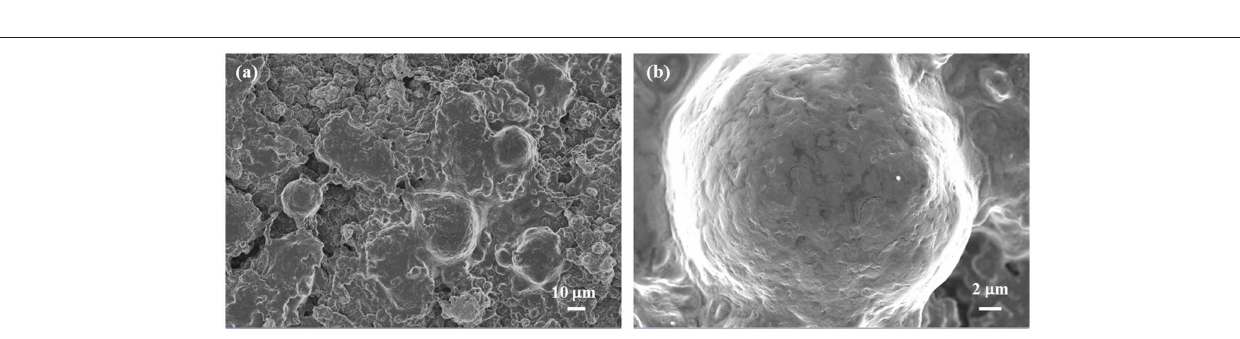
Frontiers in Chemistry |